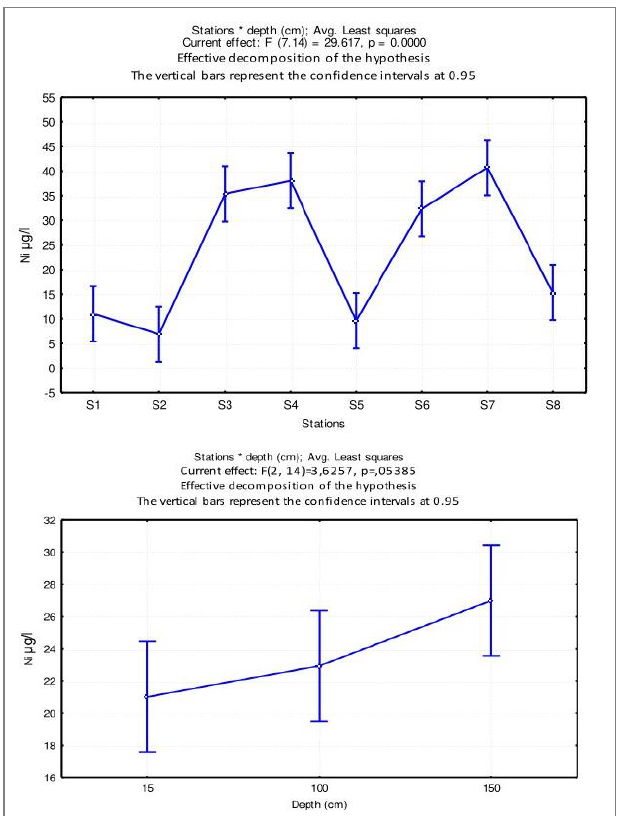
Figure 11. Spatial variation of Ni in μg/l in the Reghaia lake. Cadmium: S1P3 Station presented the maximum value (0.02 mg ∙ L-1) while the site S8P3 showed the lowest value (0.014 mg ∙ L-1). The Cd values far exceed the standards of WHO [24] (P = 0.000092) ( Figure 12 ).